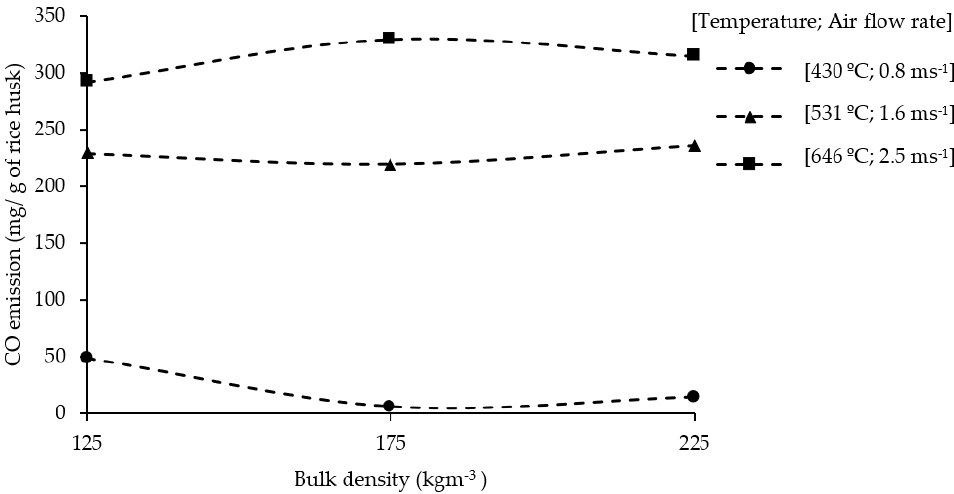
Figure 9. Cumulative CO emissions under different treatment conditions. Table 4. Summary of the main combustion experiment results.